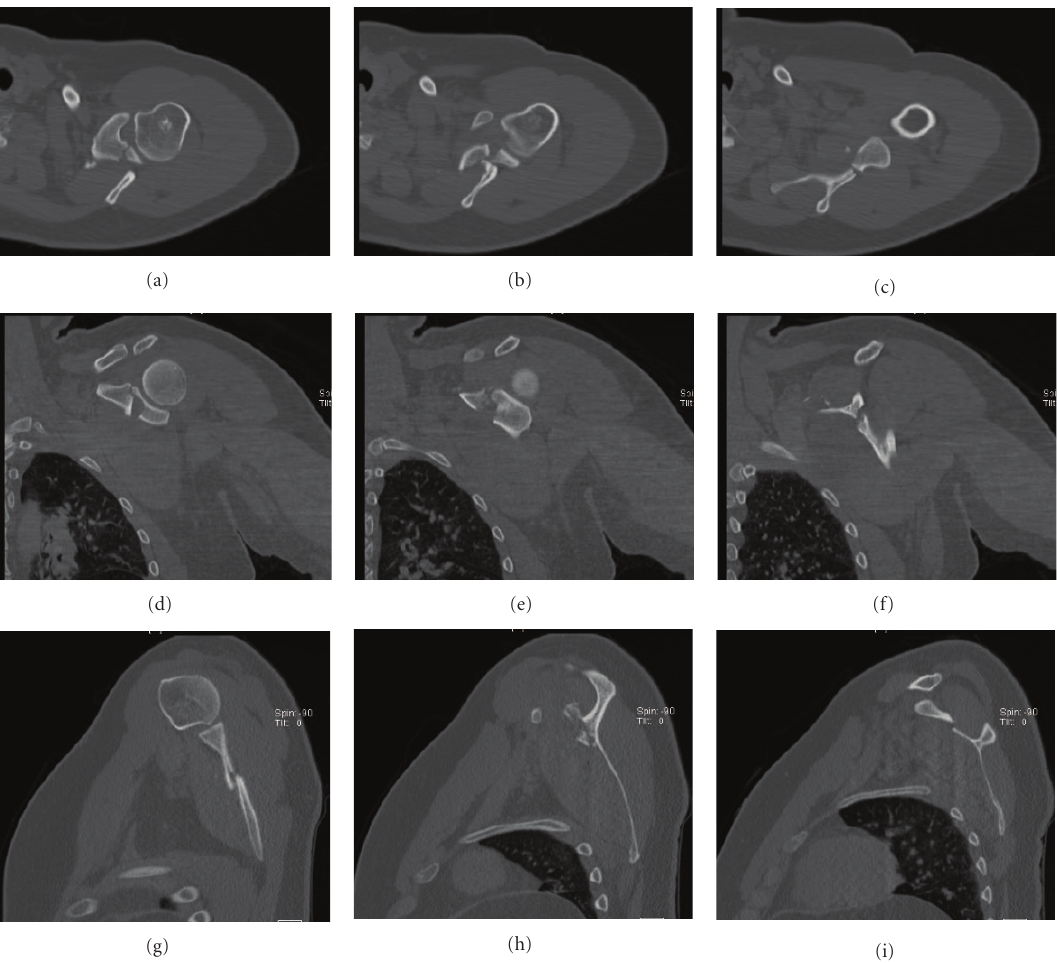
Figure 3: Axial (a–c), coronal (d–f), and saggital (g–i) cuts of the left shoulder CT scan demonstrating a displaced, comminuted scapular fracture that originates at the base of the coracoid process and extends into the posterior glenoid and into the midbody of the scapula.